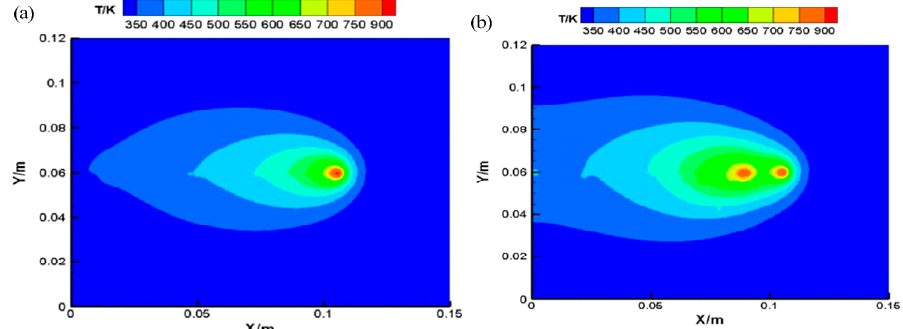
Figure 6. The temperature field of molten pool: ( a ) single laser welding brazing process, and ( b ) arc assisted laser welding brazing.